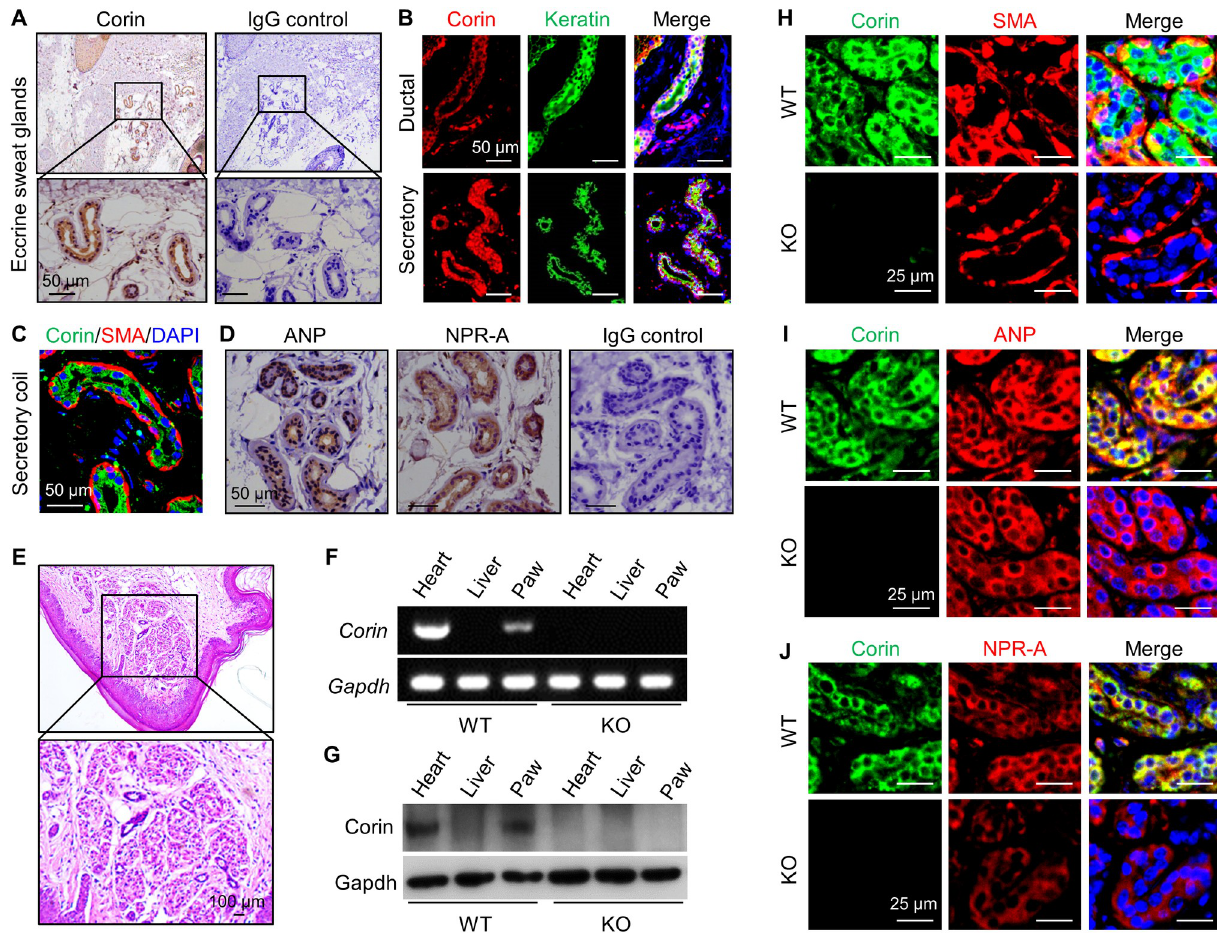
Fig 1. Corin, ANP, and NPR-A expression in human and mouse eccrine sweat glands. (A) Immunohistochemical staining of corin (brown) in human eccrine sweat glands. IgG was used in negative controls. (B) Co-staining of corin (red) and keratin (an epithelial marker) (green) in ductal and secretory epithelial cells of human eccrine sweat glands. (C) Co-staining of corin (green) and SMA (red) in the secretory epithelial cells. (D) Immunohistochemical staining of ANP and NPR-A (brown) in human eccrine sweat glands. (E) HE staining of a mouse paw skin section with eccrine sweat glands. (F and G) RT-PCR (F) and western blotting (G) analysis of corin expression in WT and corin KO mouse footpads. Hearts (positive) and livers (negative) were controls. (H–J) Co-staining of corin (green) and SMA (H), ANP (I), or NPR-A (J) (red) in eccrine sweat glands from WT and corin KO mouse footpads. Scale bars are indicated. Data are representative of at least 3 experiments in each set of the studies. ANP, atrial natriuretic peptide; HE, hematoxylin– eosin; IgG, immunoglobulin G; KO, knockout; NPR-A, natriuretic peptide receptor-A; RT-PCR, reverse transcription PCR; SMA, smooth muscle actin; WT,